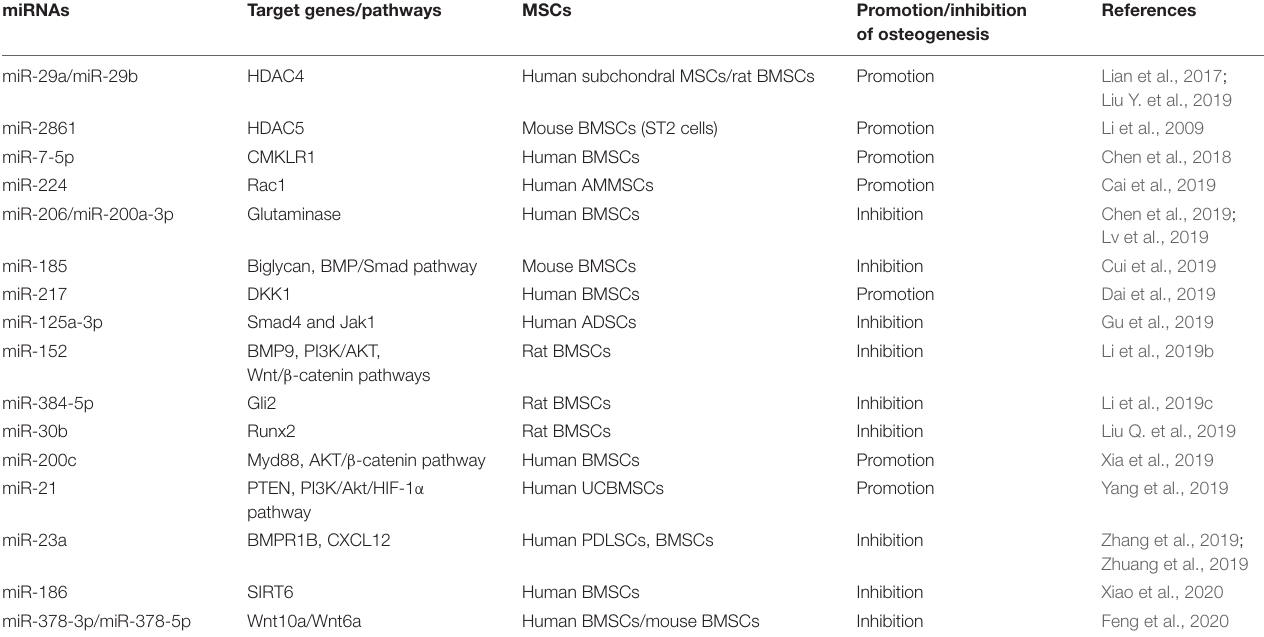
TABLE 2 | MicroRNAs involved in osteogenesis of